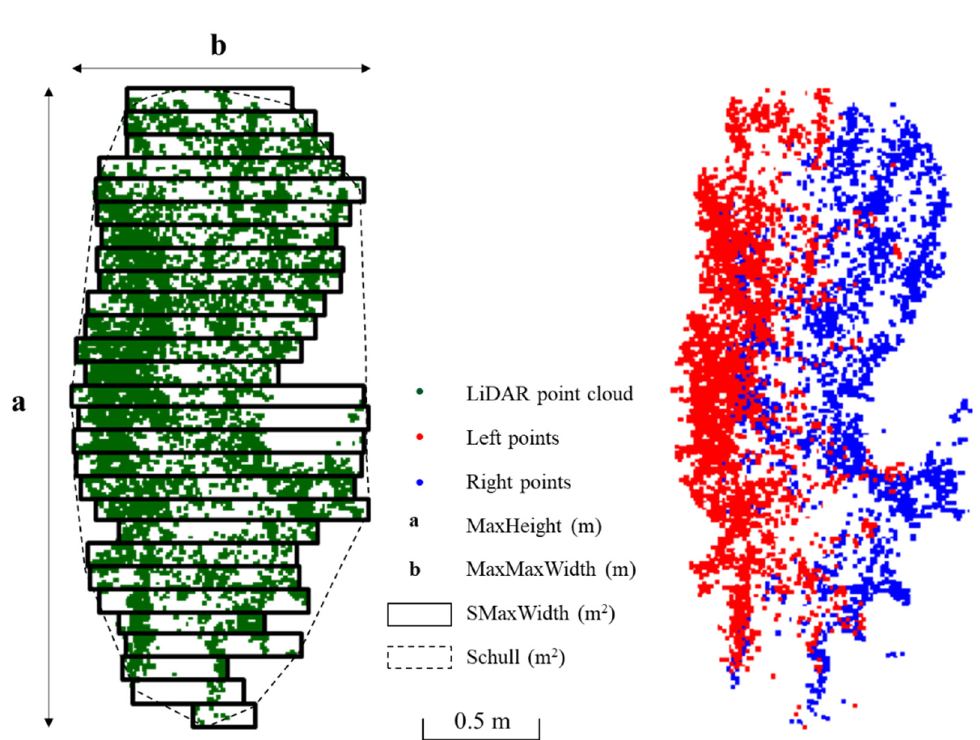
Figure 3. On the left, graphical representation of the LiDAR point cloud of a section of 0.5 m. Here, convex hull cross-sectional area (Schull) and the maximum width cross-sectional area (SMaxWidth) the convex hull cross ‐ sectional area (Schull) and the maximum width cross ‐ sectional area (SMax ‐ Width) are detailed. On the right, point cloud captured for each LiDAR scan side. are detailed. On the right, point cloud captured for each LiDAR scan